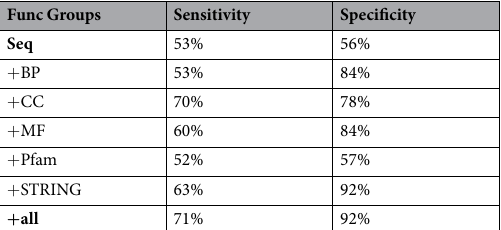
(Supplementary Table S6), whose proportion of sites is 30.80%. If our method can discriminate the substrates of SIRT1 from others, then we would expect the proportion of predicted substrates from the acetylation sites are